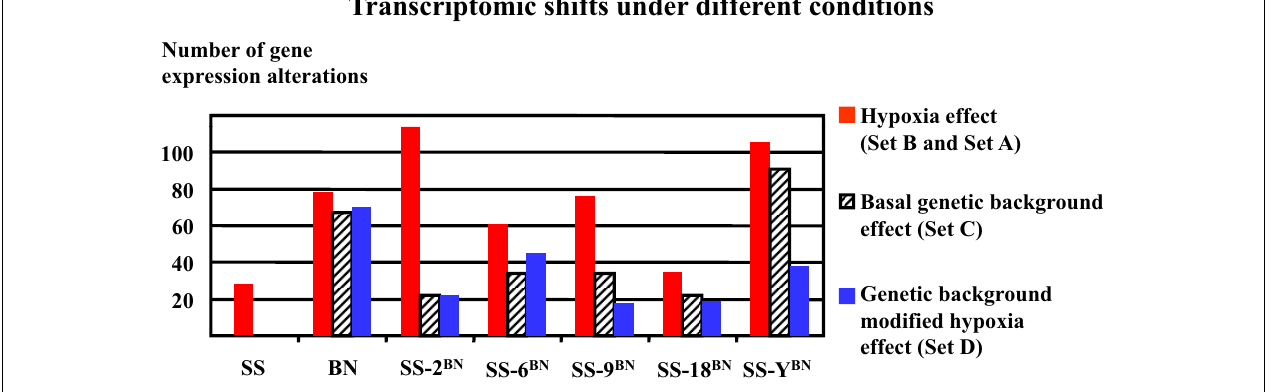
transcriptomic shifts were observed for SS and SS-18 BN .There was no obvious correlation between transcriptomic shifts and the organism’s hypoxia